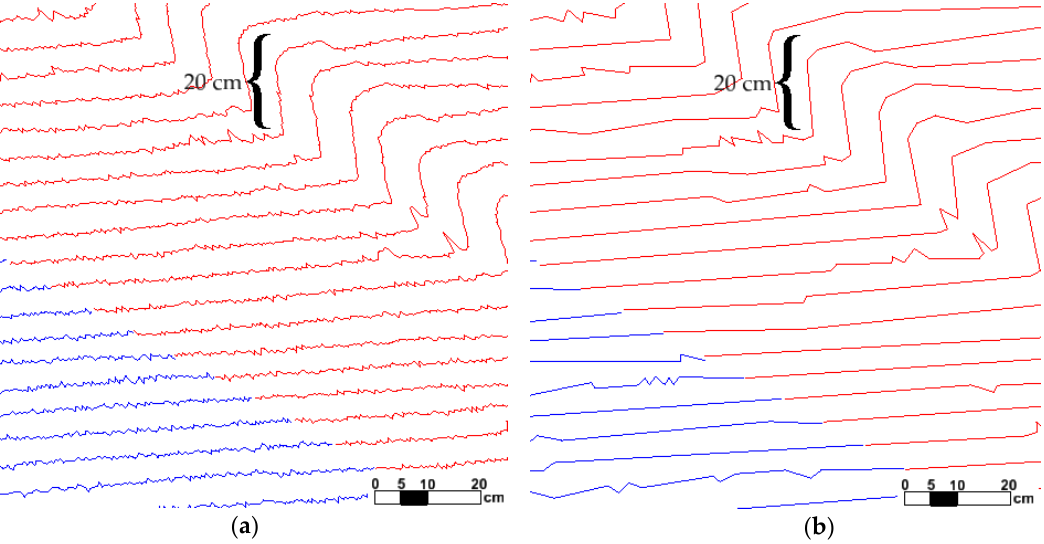
Figure 3. Isometric view of the vertical Douglas–Peucker algorithm application result: ( a ) original TCS and ( b ) vertical smooth result.